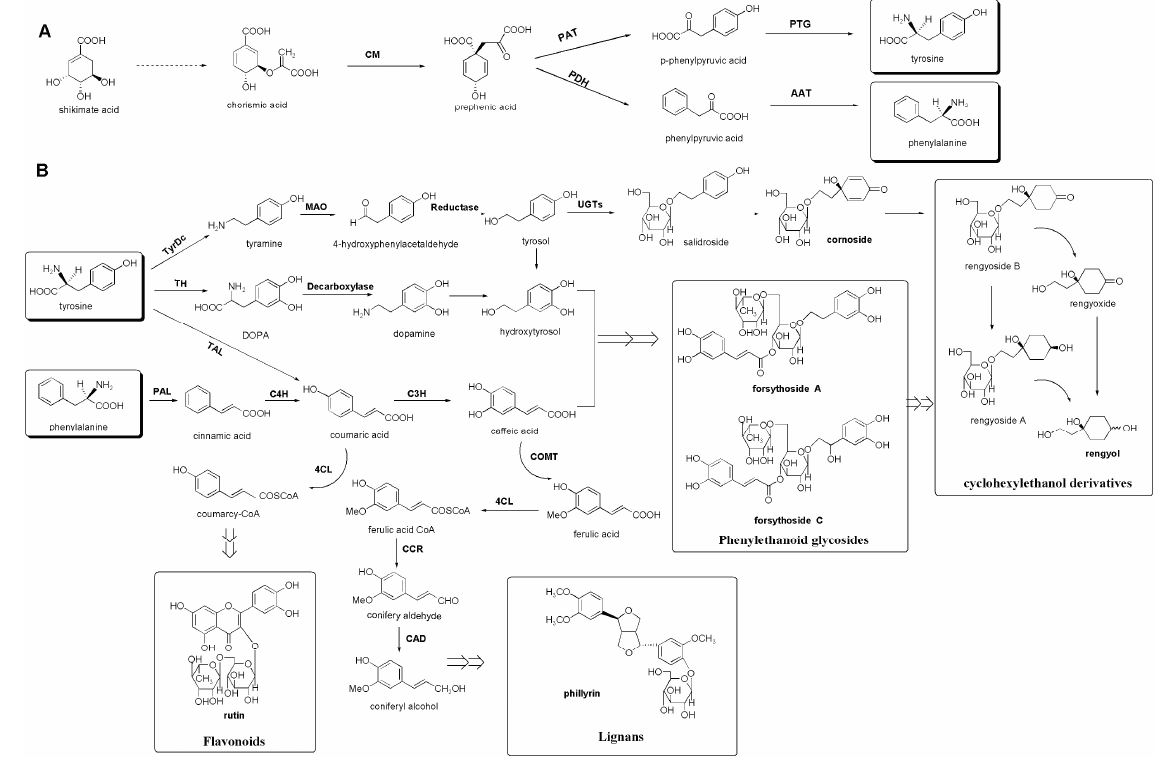
Figure 4. Putative biosynthetic pathways of the major secondary metabolites in FF.